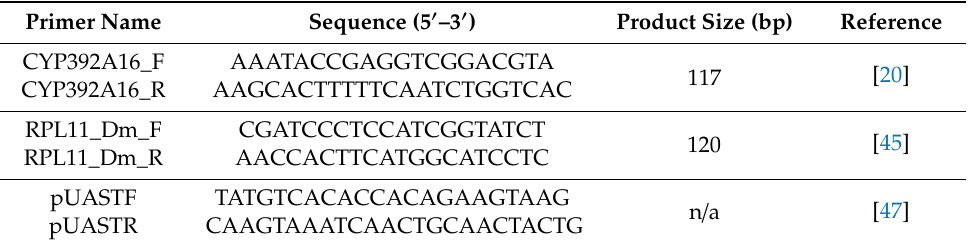
Table 1. Primers used in this